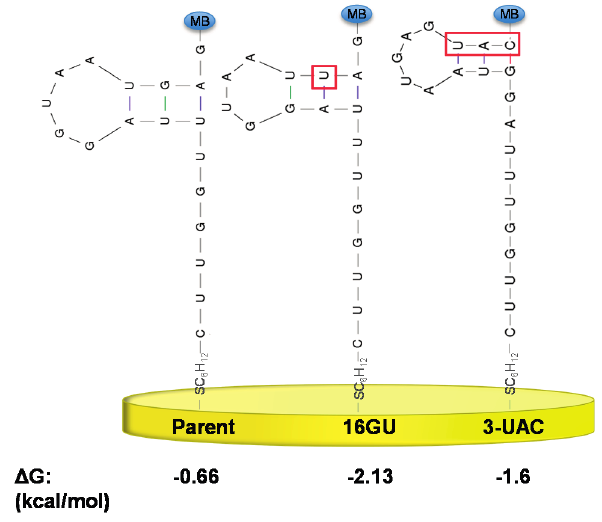
Figure 5. We aimed to alter the aptamer sequences to develop stabilized target-free states while maintaining a similar secondary structure to the high-gain parent sequence. The sequence mutations (highlighted in red boxes) attempt to stabilize the internal loop structure at the 3'-distal end. Free energies of each structure were calculated using MFOLD as described above